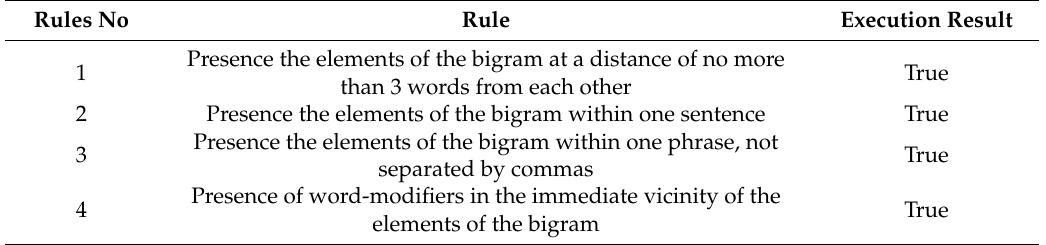
Table 14. Rules for Detecting the Presence of Elements of the Sentiment Dictionary in the